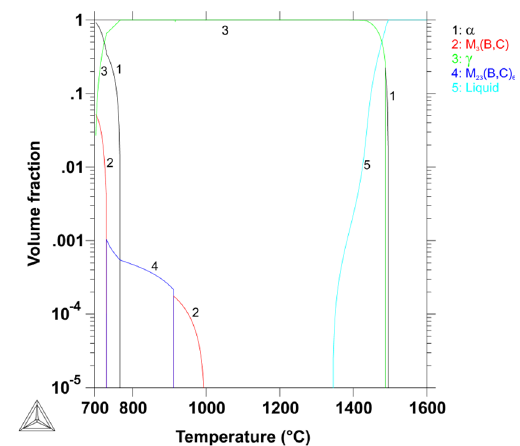
Figure 6. Volume fraction of phases calculated with steel composition from Table 1.